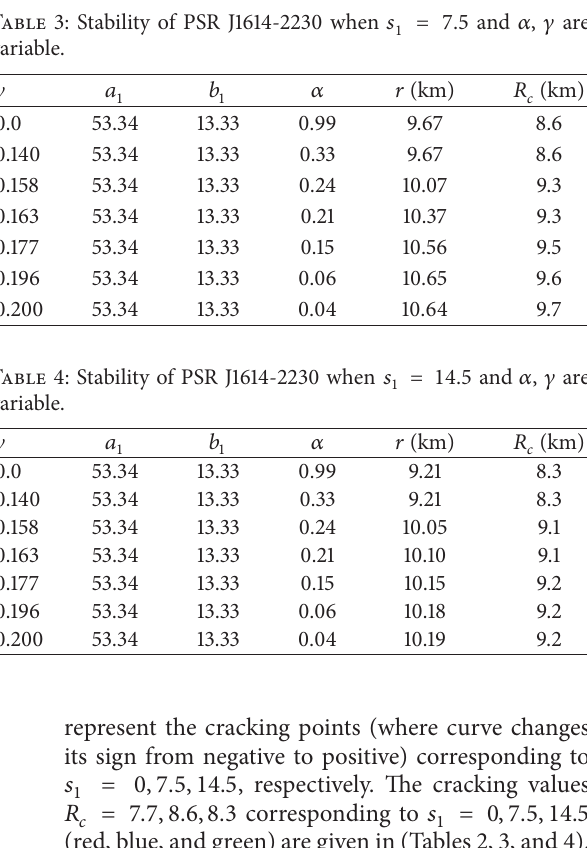
Figure 1: Plots show that there is no cracking; that is, the PSR J1614- 2230 remains stable for different values of the parameters involved in the model given in Table 1, when 𝐸 = 0 in quadratic regime.